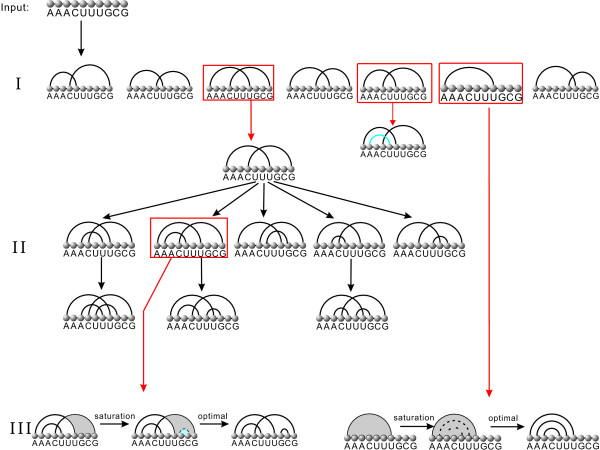
An outline of Cross. For illustration purposes we assume here σ = 1. The routines SHADOW, SKELETONBRANCH and SATURATION are depicted. Due to space limitations we only represent a few select motifs and for the same reason only one of the motifs displayed in the first row is extended by one arc (drawn in blue). Furthermore note that only motifs with crossings give rise to nontrivial skeleton-trees, all other motifs are considered directly as input for SATURATION.